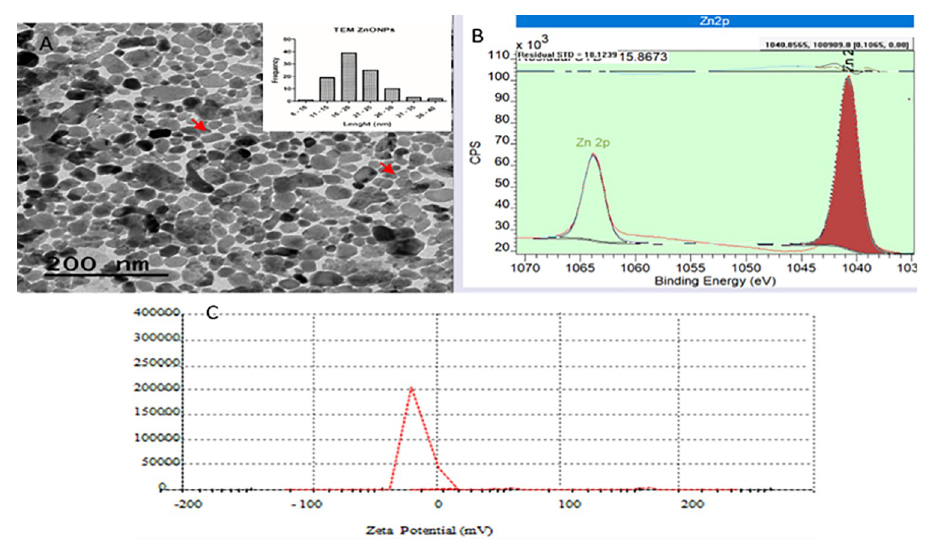
Fig 3. TEM image of the ZnO NPs showing rod-shaped particles without aggregation (A) The average size by XRD spectrum (B) zeta potential of ZnO NPs (C).